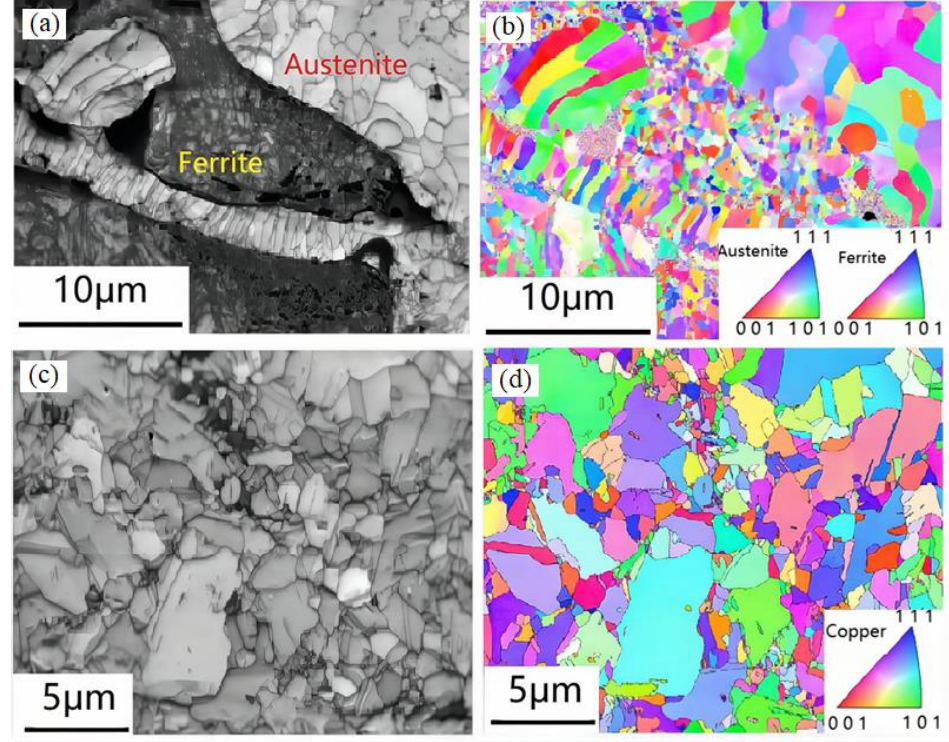
Figure 11. EBSD images of the composite coating: ( a ) IQ map of high-carbon steel area; ( b ) IPF map of high-carbon steel area; ( c ) IQ map of aluminum bronze area; and ( d ) IPF map of aluminum bronze area.